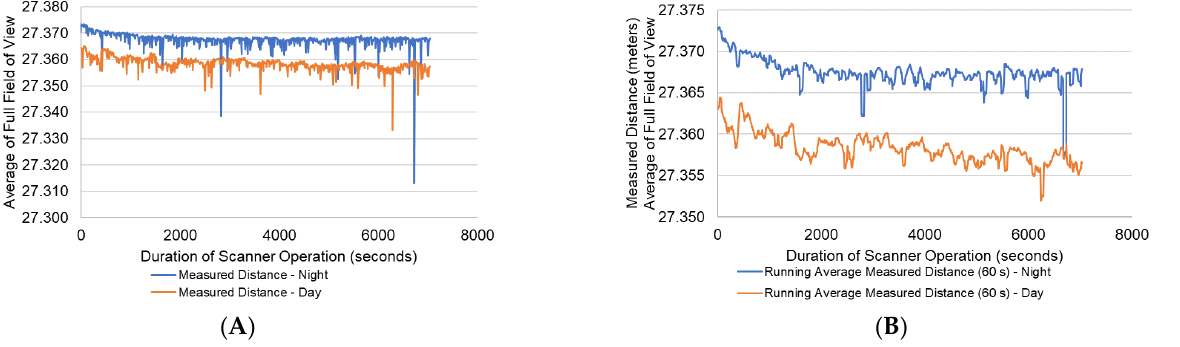
Figure 29. ( A ) Average measured distance and ( B ) running average measured distance per 60 s of the Livox ® Mid–40’s field of view over time during outdoor accuracy assessments.